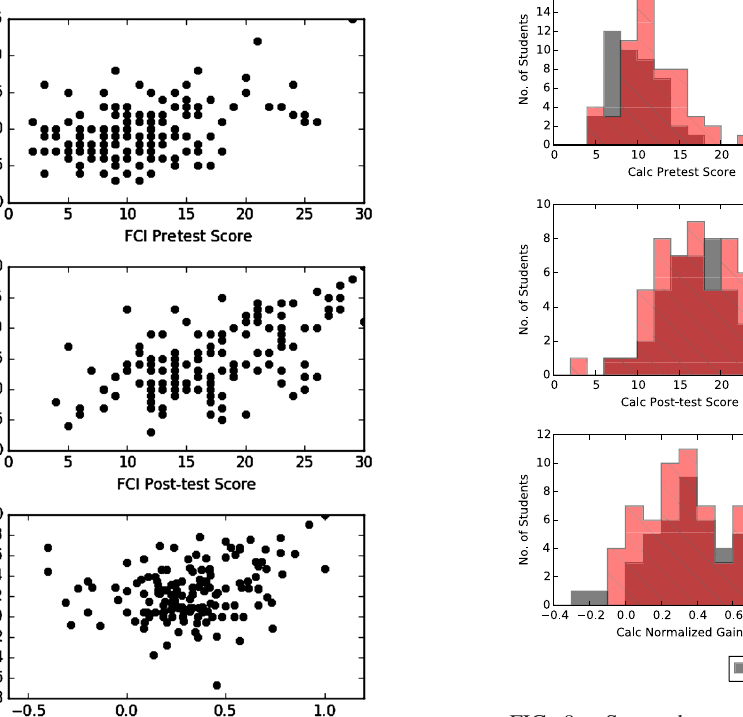
FIG. 9. Scores by gender. Top: Pretest scores of EMCA for calculus- and algebra-based courses. Middle: Post-test scores of EMCA for calculus- and algebra-based courses. Bottom: Nor- malized gain values of EMCA for calculus- and algebra-based courses. A Spearman rank correlation test analysis shows that there is no statistically significant correlation between the post- test and normalized gain values for the 2015 and 2016